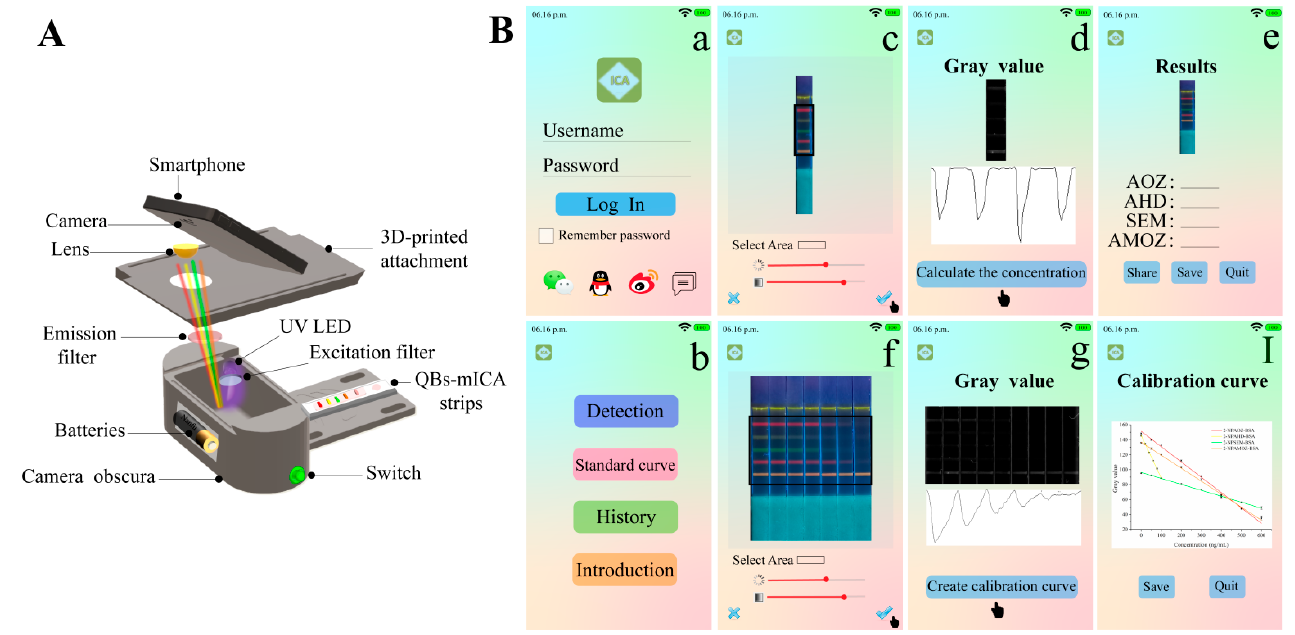
Figure 6. ( A ) The internal structure of smartphone-based immunochromatography reader, and ( B ) the interfaces of analysis smartphone application.